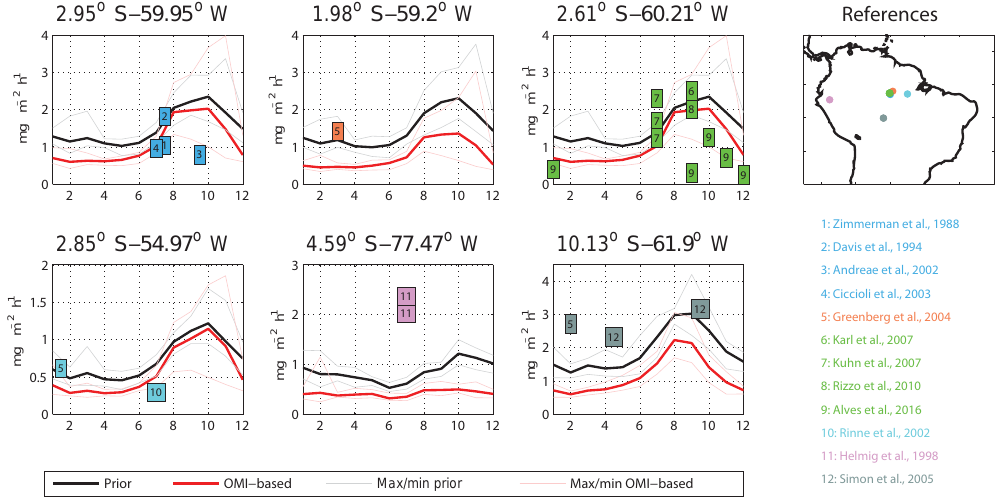
Figure 10. Comparison of a priori (black) and satellite-based (red) isoprene fluxes with ground-based flux measurements (colored numbered squares). The a priori and a posteriori isoprene fluxes are averaged over the full period from 2005 to 2013 for the grid. To ensure meaningful comparison, the ground-based flux measurements are corrected for the diurnal variation in isoprene fluxes; cf. Table S1 for more